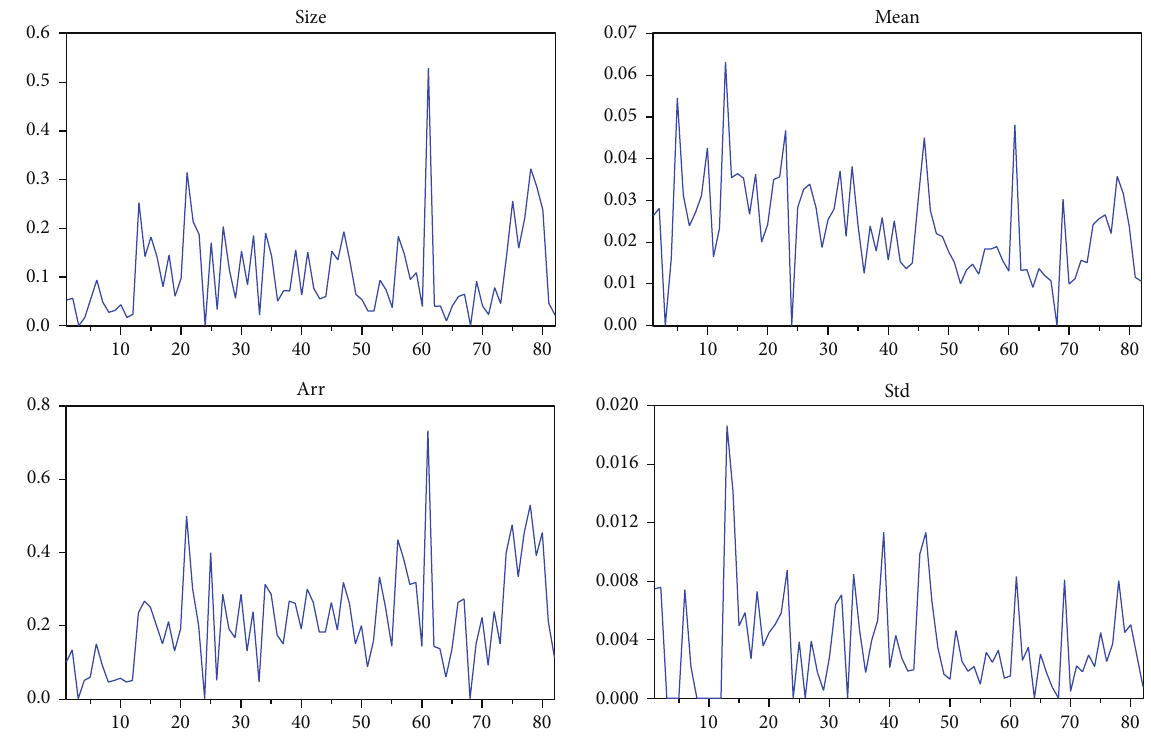
Figure 5: Time series characteristic of individual